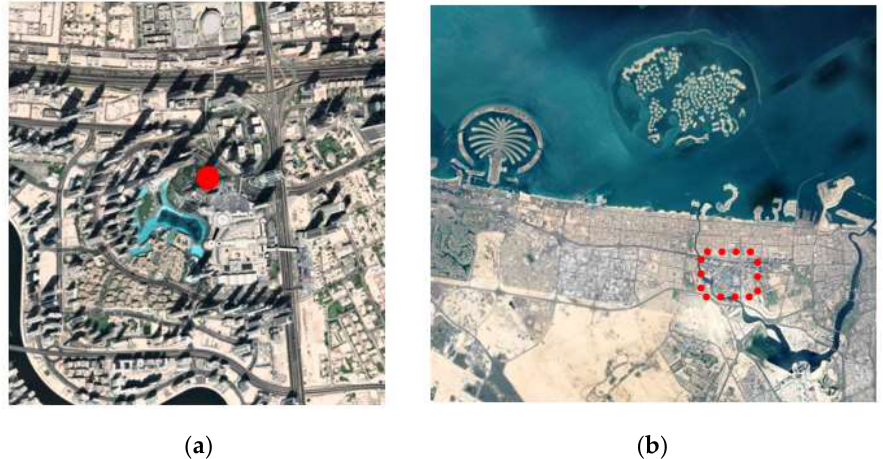
Figure 6. ( a ) Tower neighbourhood map, ( b ) location map of Burj Khalifa. Source:[19].